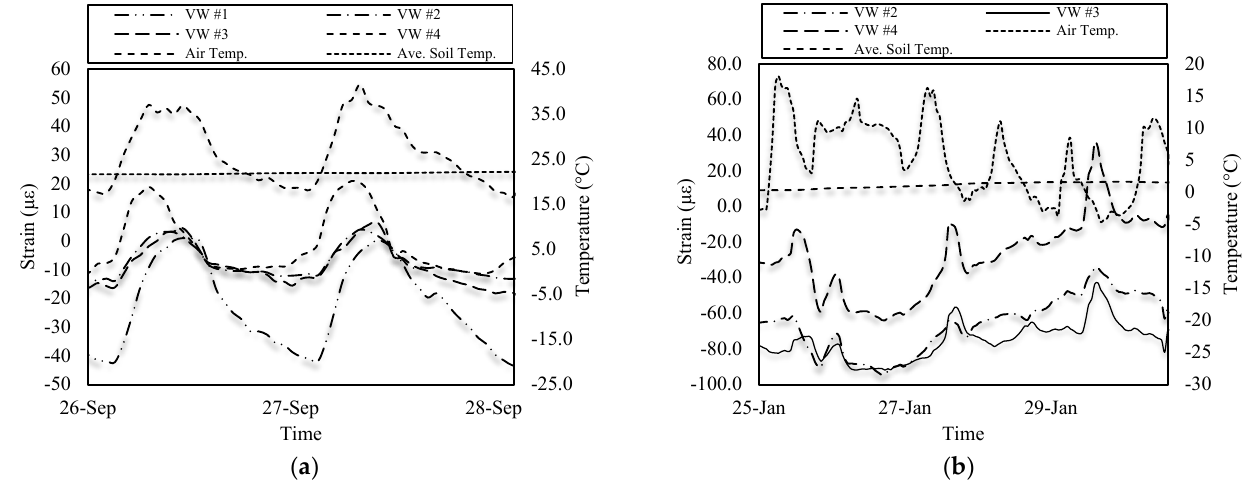
Figure 13. Measured temperatures and displacements ( a ) warm weather strain gauge movements ( b ) cold weather strain gauge movement.